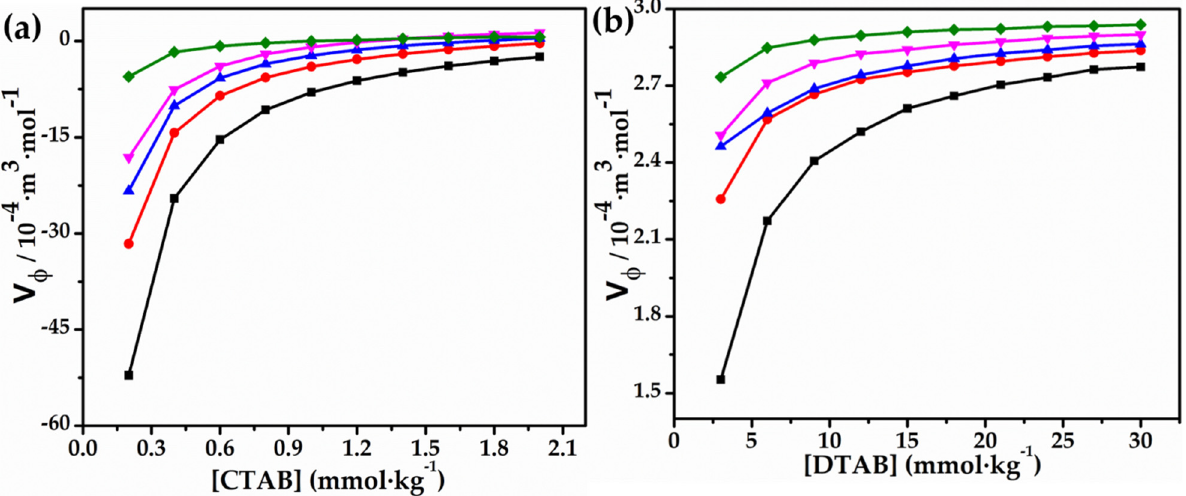
 Figure 2. Plots of s versus ( a ) [CTAB] and ( b ) [DTAB] in 0.010 mol∙kg –1 aqueous solution of Figure 3. Plots of ϕ V versus ( a ) [CTAB] and ( b ) [DTAB] in 0.010 mol ∙ kg –1 aqueous solution of glycyl Figure 3. Plots of V ϕ versus ( a ) [CTAB] and ( b ) [DTAB] in 0.010 mol · kg − 1 aqueous solution of glycyl glycyl dipeptide 293.15 K ( ■ ), 298.15 K (●), 303.15 K ( ▲ ), 308.15 K ( ▼ ) and 313.15 K ( ◆ ). dipetide293.15 K ( (cid:4) ), 298.15 K ( • ), 303.15 K ( (cid:78) ), 308.15 K ( (cid:72) ) and 313.15 K ( dipetide293.15 K ( ■ ), 298.15 K ( ● ), 303.15 K ( ▲ ), 308.15 K ( ▼ ) and 313.15 K ( ◆ ). Table 3. Apparent molar volume,  V /10 −4 (m 3 ∙mol −1 ) values for CTAB and DTAB in pure water and 0.001, 0.005 and 0.010 mol∙kg −1 aqueous solution of glycyl dipeptide at different temperatures and pressure p = 100 kPa.